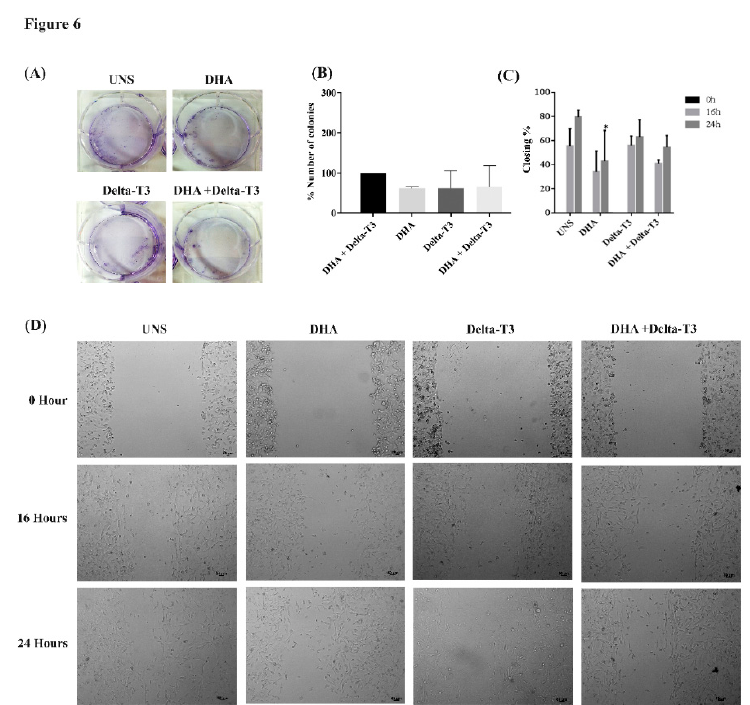
Figure 6. Clonogenic and cell migration. ( A ) Images and ( B ) percentage of the number of MDA-MB-231 colonies treated with DHA (50 µ M), Delta-T3 (5 µ M) and co-treatment were assessed by clonogenic assay. Cell migration was analyzed by wound healing assay and quantified in percentage ( C ) and representative images at 0, 16 and 24 h ( n = 3) ( D ). Images are representative of three independent experiments.